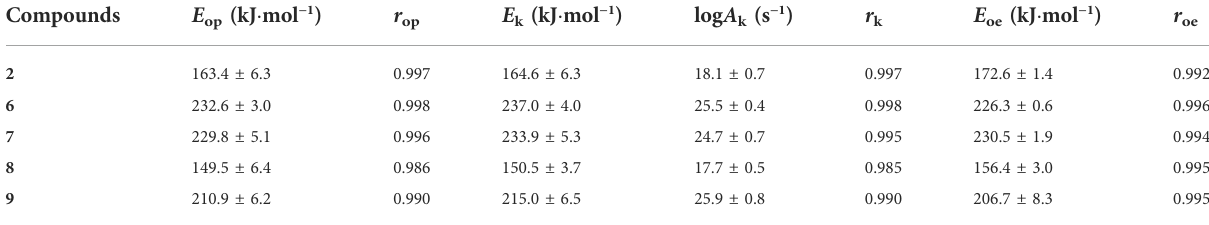
TABLE 1 The kinetic parameters of compounds 2 and 6 – 9.